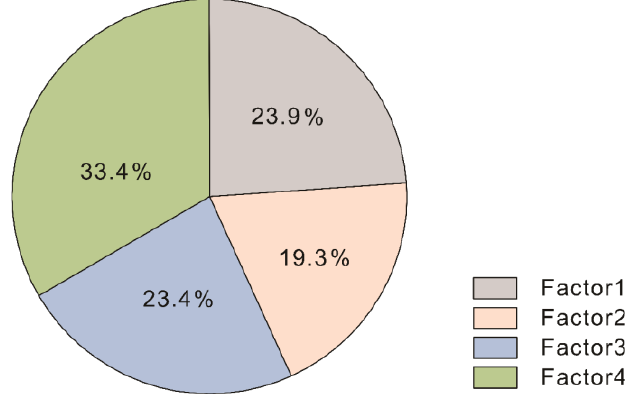
Figure 6. Proportion of heavy metal pollution sources.